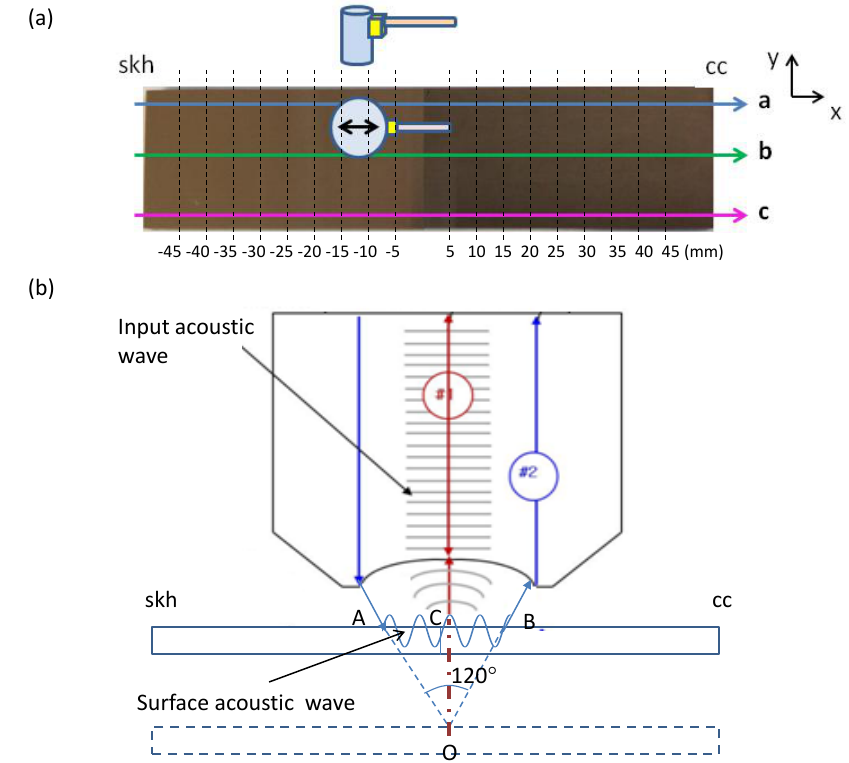
Figure 1. Acoustic sources used in this study. ( a ) Acoustic transducer. The sensor head was switched between the longitudinal-wave and shear-wave modes for the respective measurements. The grid points indicated on the specimen are the points where the acoustic measurements were made; ( b ) Point-focused acoustic source for Scanning Acoustic Microscopy. Acoustic frequencies of 400 and 200 MHz were used with the same focusing acoustic